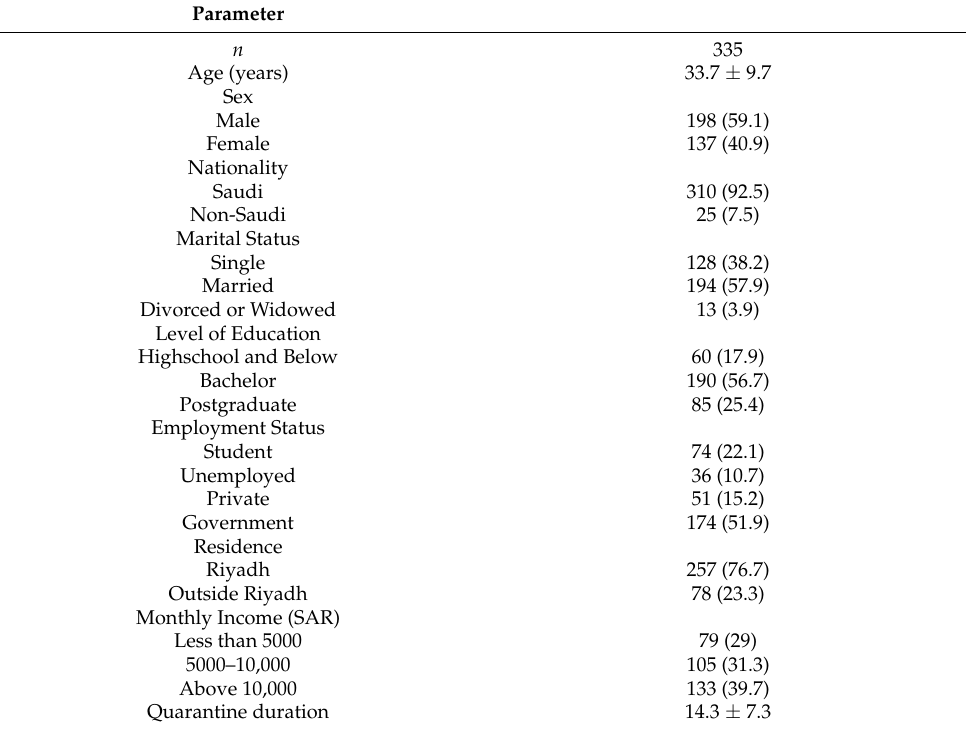
Table 1. Demographic characteristics of